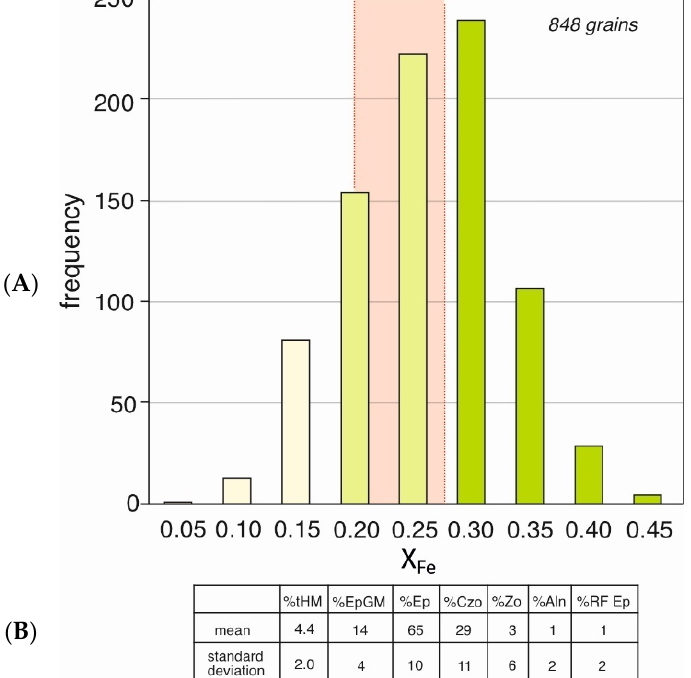
Figure 7. Epidote group minerals in Quaternary Bengal Fan turbidites. ( A ) Distribution of X Fe values as determined for 848 grains using the new Raman library. The pink rectangle marks the transition between optically negative epidote (Ep > 30; X Fe > 0.27) and positive clinozoisite (Ep < 30; X Fe < 0.20). Intermediate values were assigned to epidote if ν 4 ≥ 3369 cm − 1 and to clinozoisite if ν 4 < 3369 cm − 1 . ( B ) Average composition: tHM, transparent heavy minerals; EpGM, epidote group minerals; Ep, epidote; Czo, clinozoisite; Zo, zoisite; Aln, allanite; RF Ep, epidote-bearing rock fragments.